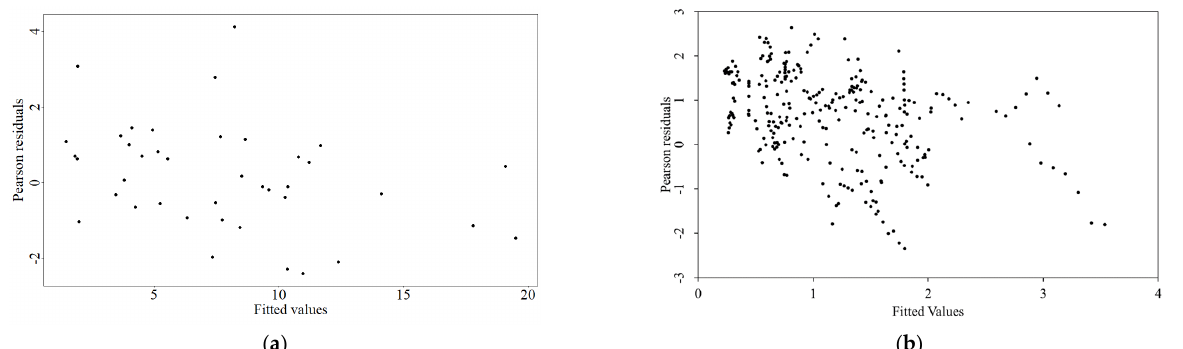
Figure 6. Pearson residuals vs. fitted values: ( a ) for Model 0; ( b ) for Model 3.